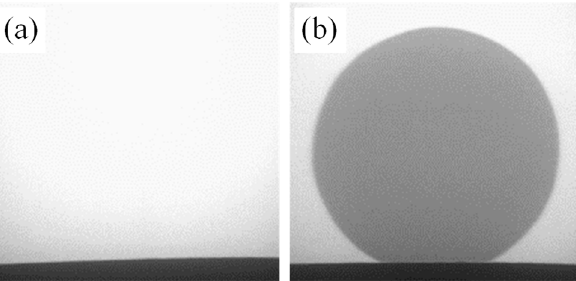
Figure 8. X-ray transmission images of ( a ) carbon sheets and ( b ) precursor between carbon sheets.